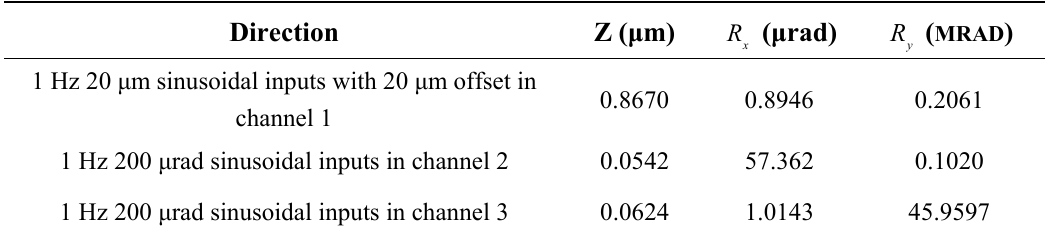
Table 3. Model prediction error if random inputs were